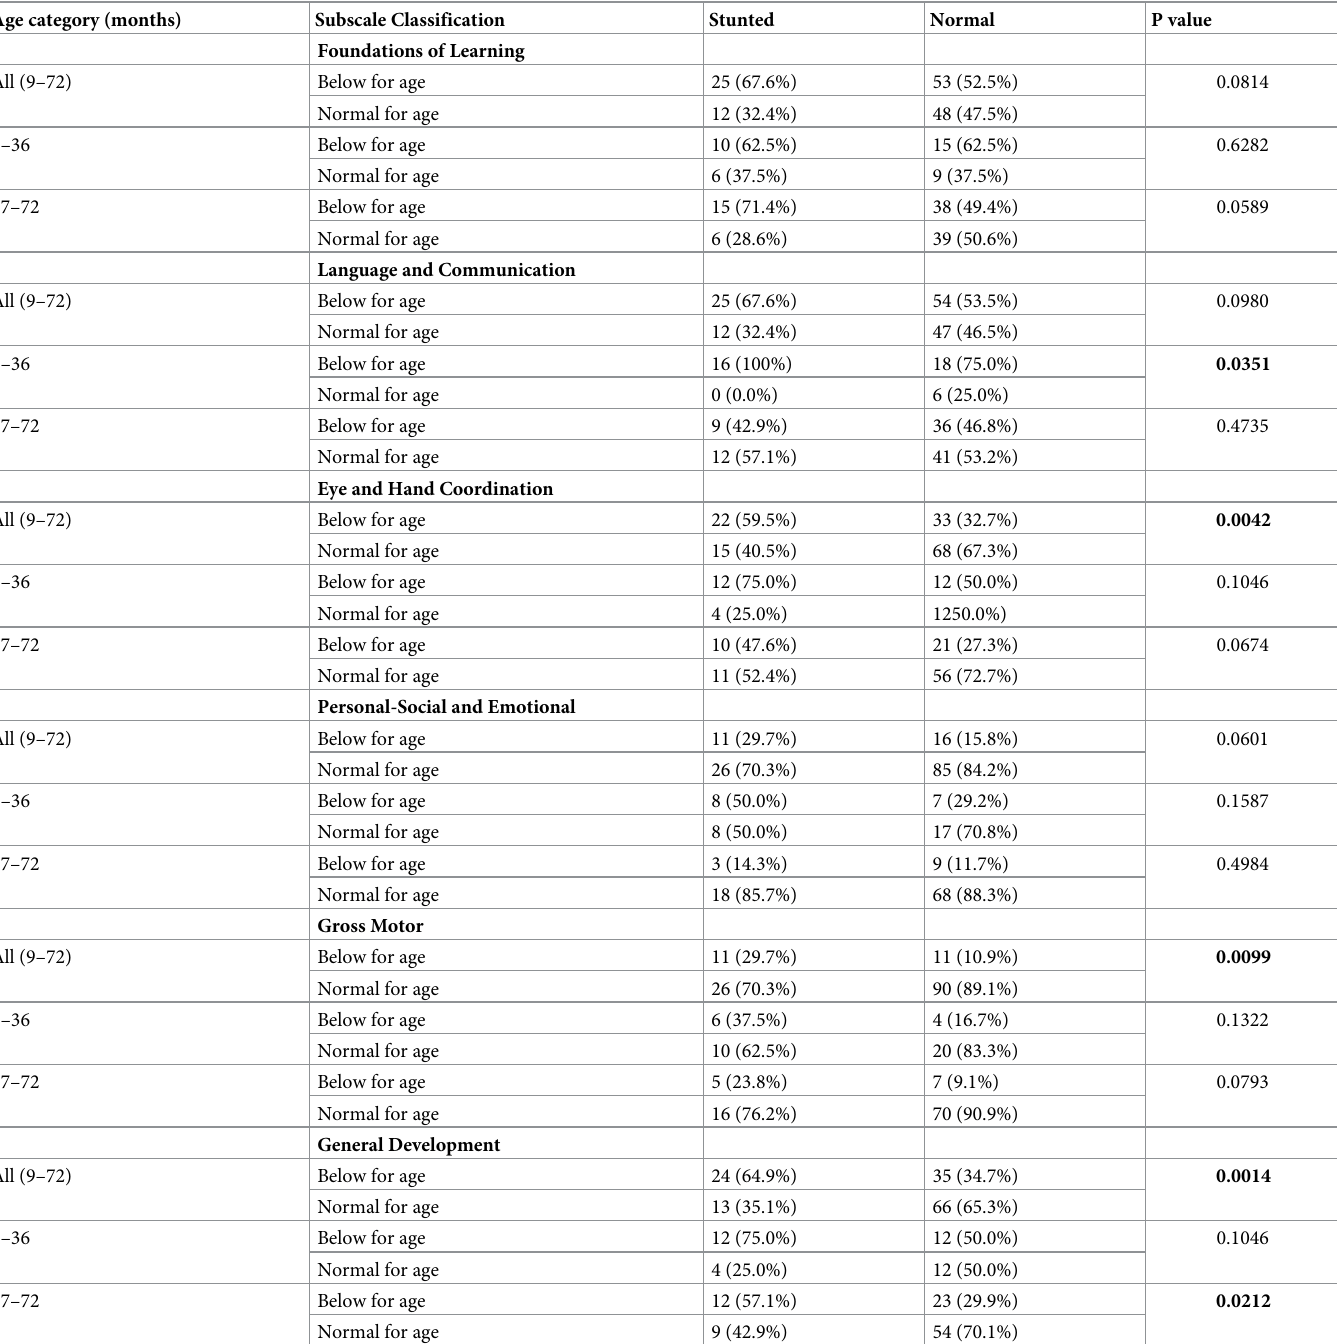
Table 3. Cognitive performance classification based on stunting